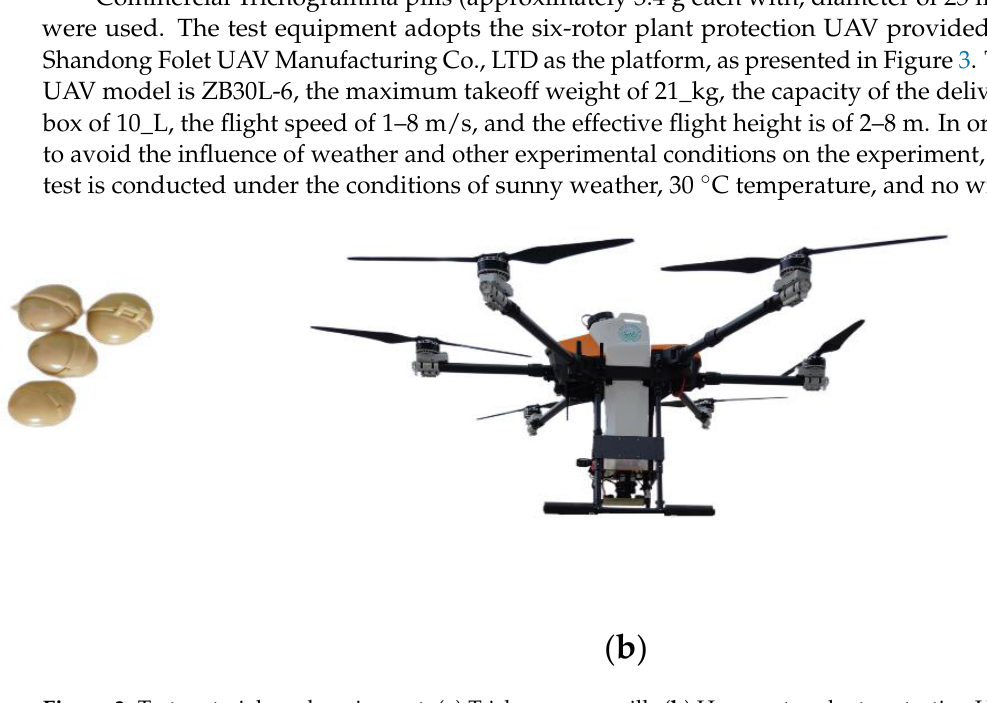
Figure 3. Test materials and equipment. ( a ) Trichogramma pills ( b ) Hexacopter plant protection UAV.